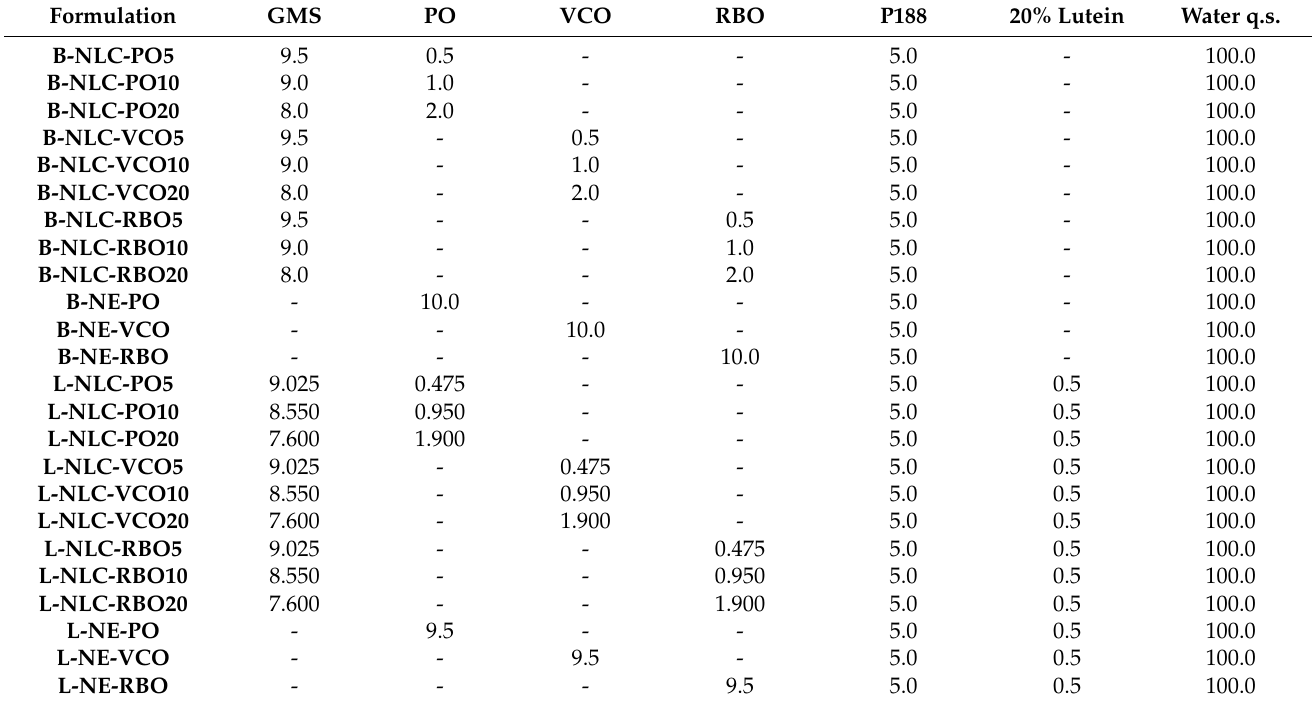
Table 1. Compositions of lutein-free and lutein-loaded lipid nanocarriers (% w / w